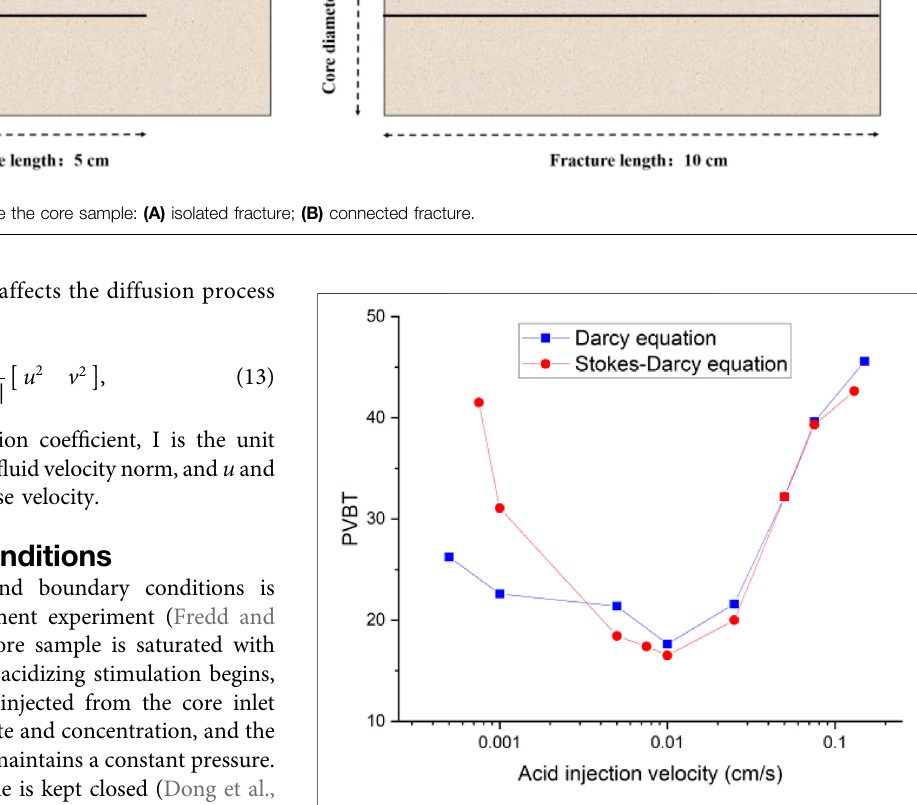
FIGURE 2 | Matrix acidizing curves of pore volume to